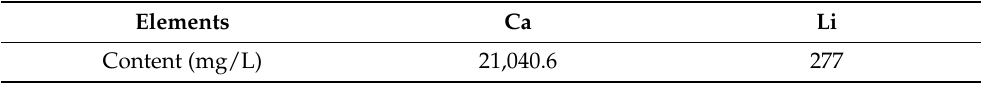
Table 1. Analyze the composition of the solution before oxalic acid